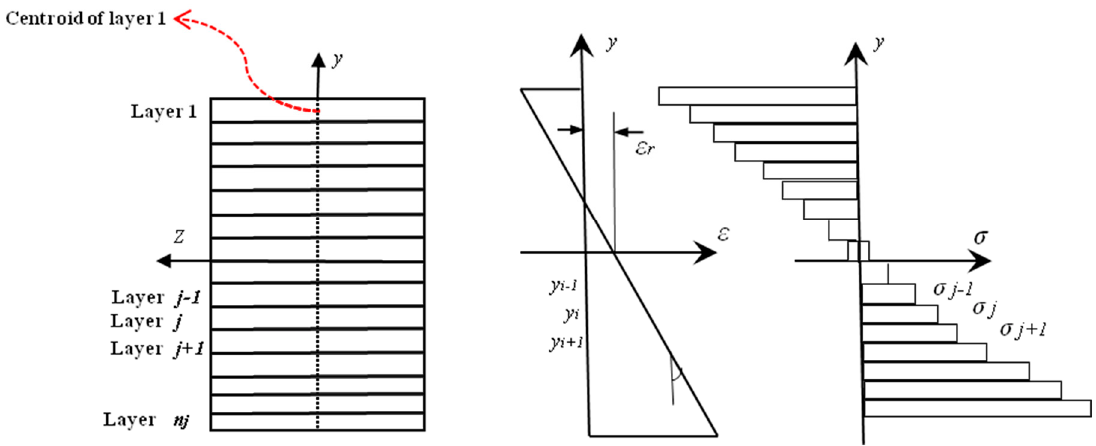
Figure 4. Cross sectional discretisation, strain and stress diagram.